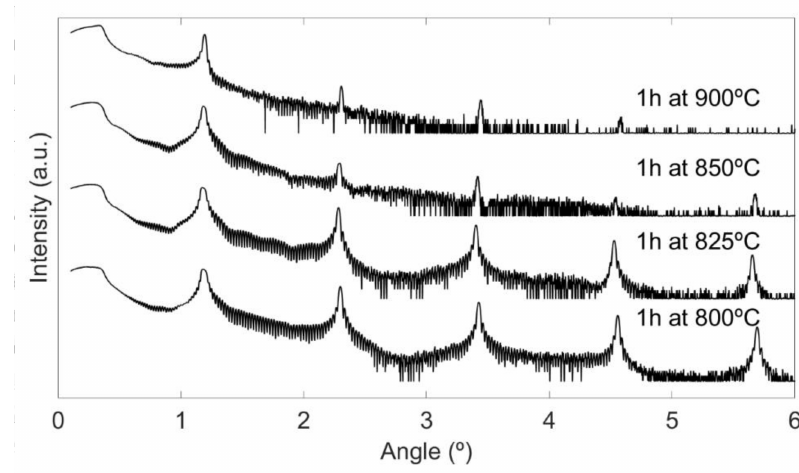
Figure 4. SAXRD spectra of a short (~3.8 nm) period WC/SiC after being annealed to 800 ◦ C, 825 ◦ C, 850 ◦ C and 900 ◦ C. This multilayer consists of 50 bilayers.